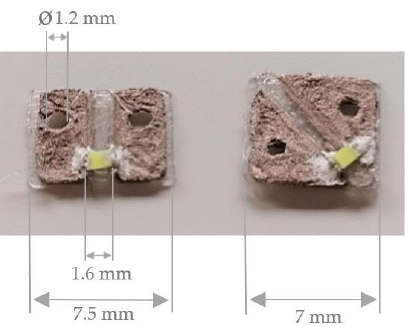
Figure 18. 3D printed PLA LED sequins with conductive filament Electrifi from Multi3D and equipped with